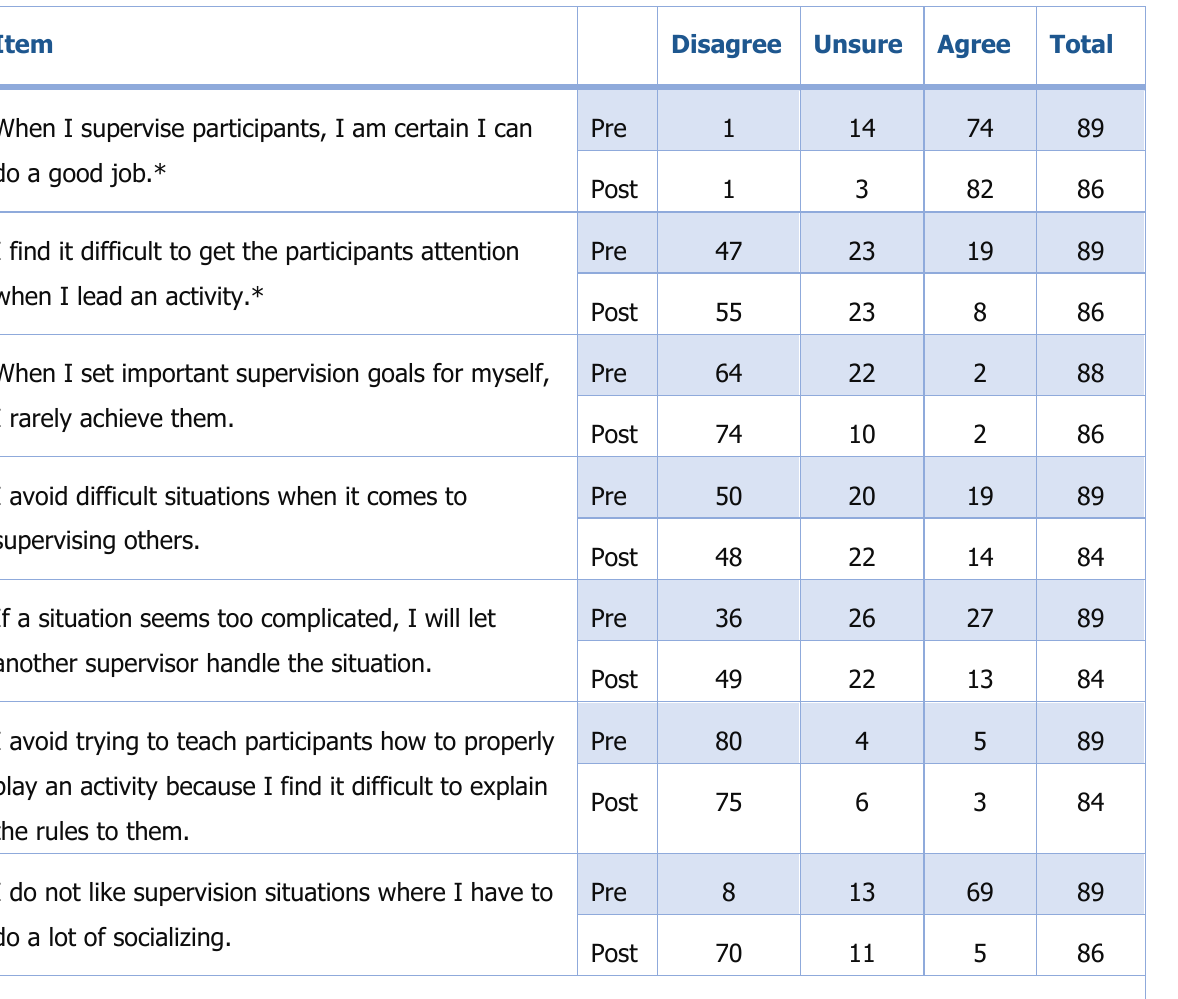
Table 1. Future Youth Workers’ Openness to the Challenge and Responsibility of Supervision